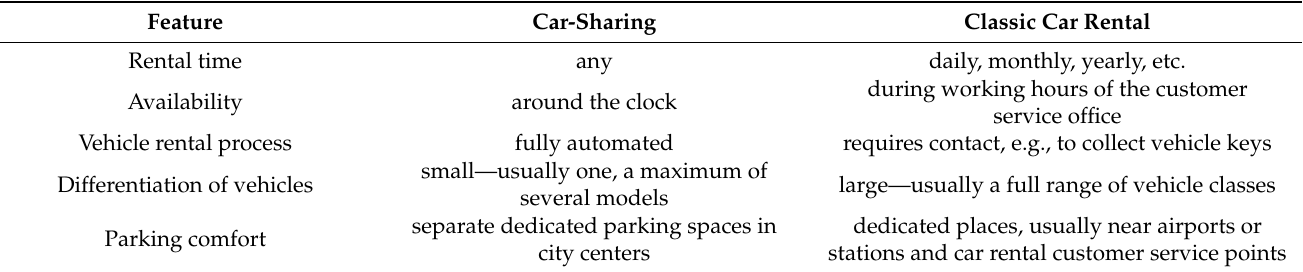
Table 4. Comparison of the classic car rental and car-sharing